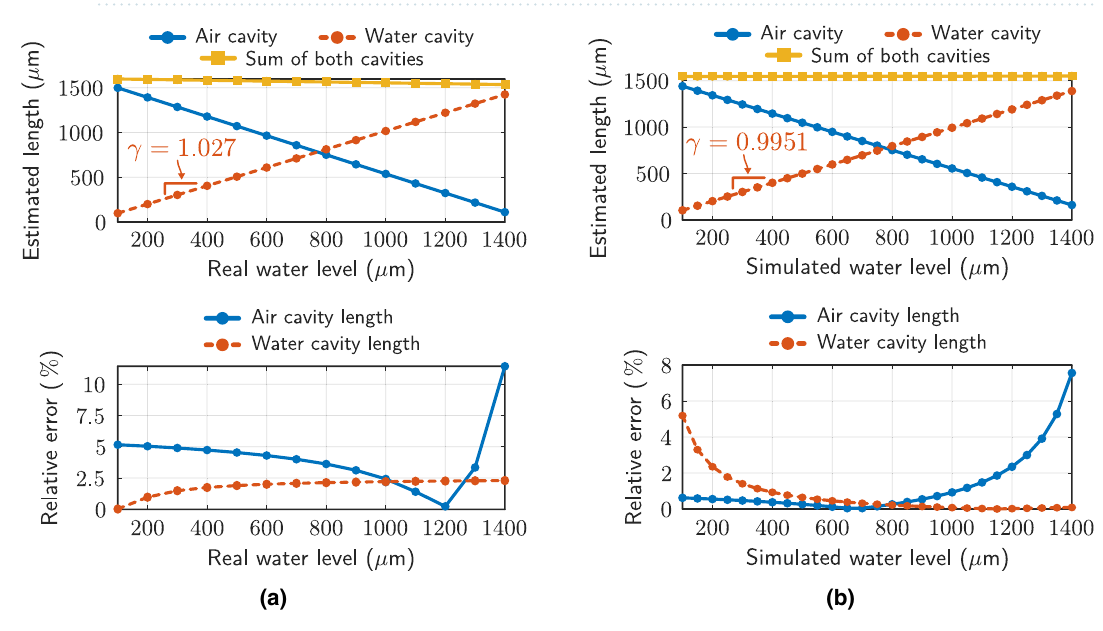
Figure 9. ( a ) Estimated cavity length (air and water) and relative error for different real water levels. ( b ) Estimated cavity length (air and water) and relative error for different simulated water